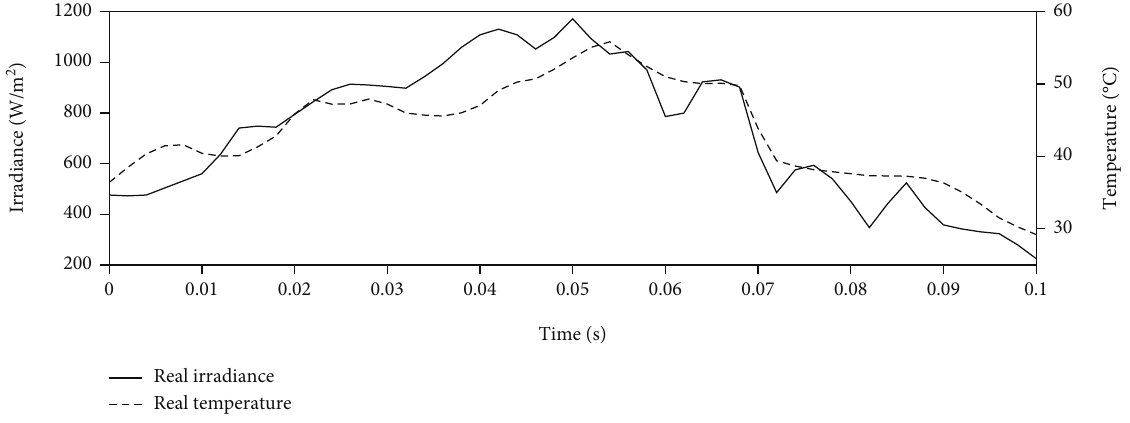
Figure 23: Real-time irradiance and temperature.